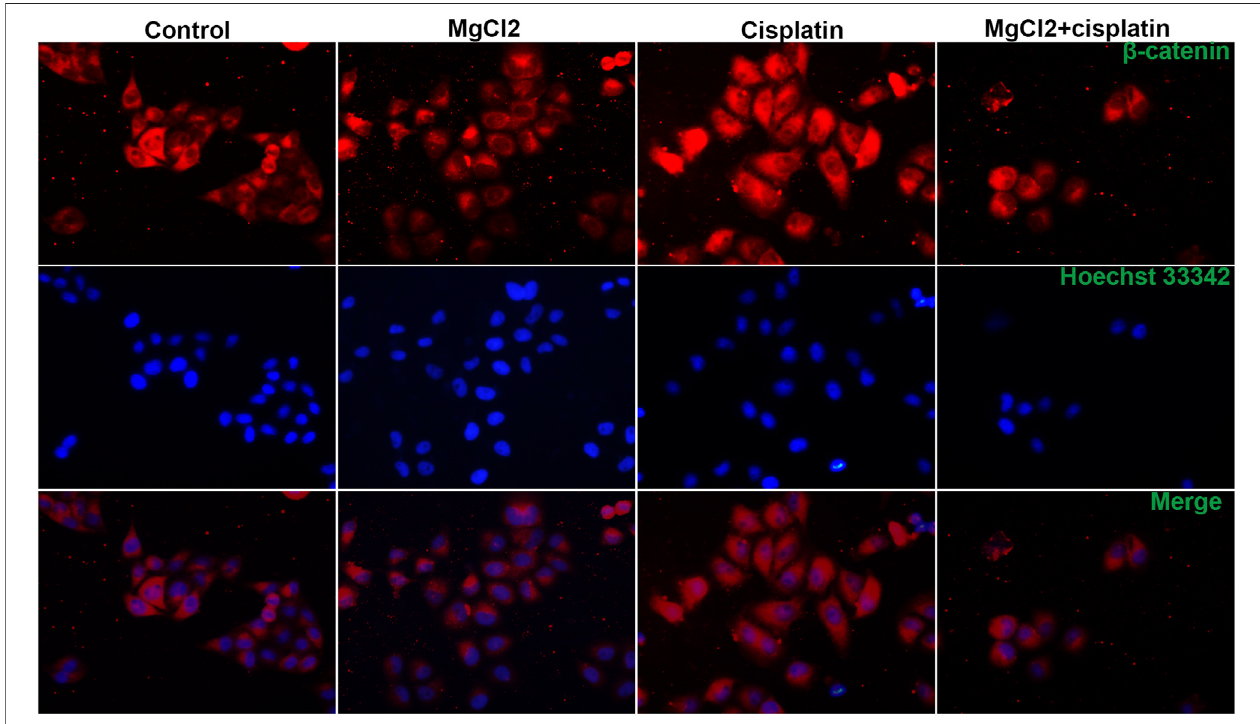
FIGURE 5 | Distribution of β -catenin in UC3 bladder cancer cells that received combinatorial treatment with MgCl 2 and cisplatin as determined by immuno fl uorescence. The immuno fl uorescence intensity was showed in Supplementary Figure S9 .